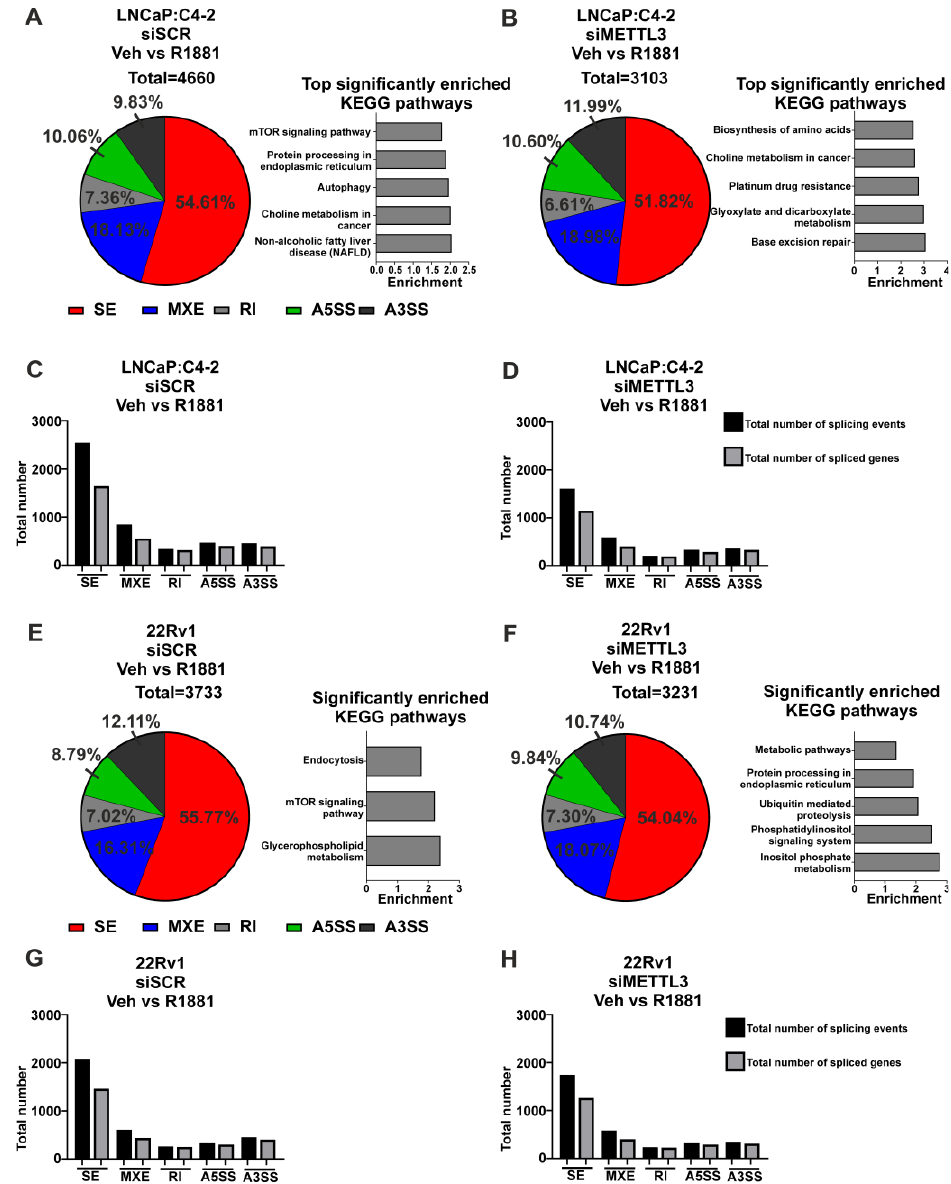
Figure 5. Knockdown of METTL3 influences androgen-induced splicing in PCa cell lines. PCa cells treated with − /+ 1nM R1881 and − /+ siMETTL3 were analysed by RNA-seq and the DSGs deter- mined. The significant androgen-regulated differential splicing events, genes, and top significantly enriched KEGG pathways in siSCR Veh vs. R1881 and siMETTL3 Veh vs. R1881 in LNCaP:C4-2 ( A – D ) and 22Rv1 ( E – H ) are shown. Significant splicing events: dPSI ≥ 5% and FDR < 0.05. Veh = vehicle, FC = fold-change, FDR = false discovery rate. SE = skipped exon, MXE = mutually exclusive exon, RI = retained intron, A5SS = alternative 5′ splice site, A3SS = alternative 3′ splice site.